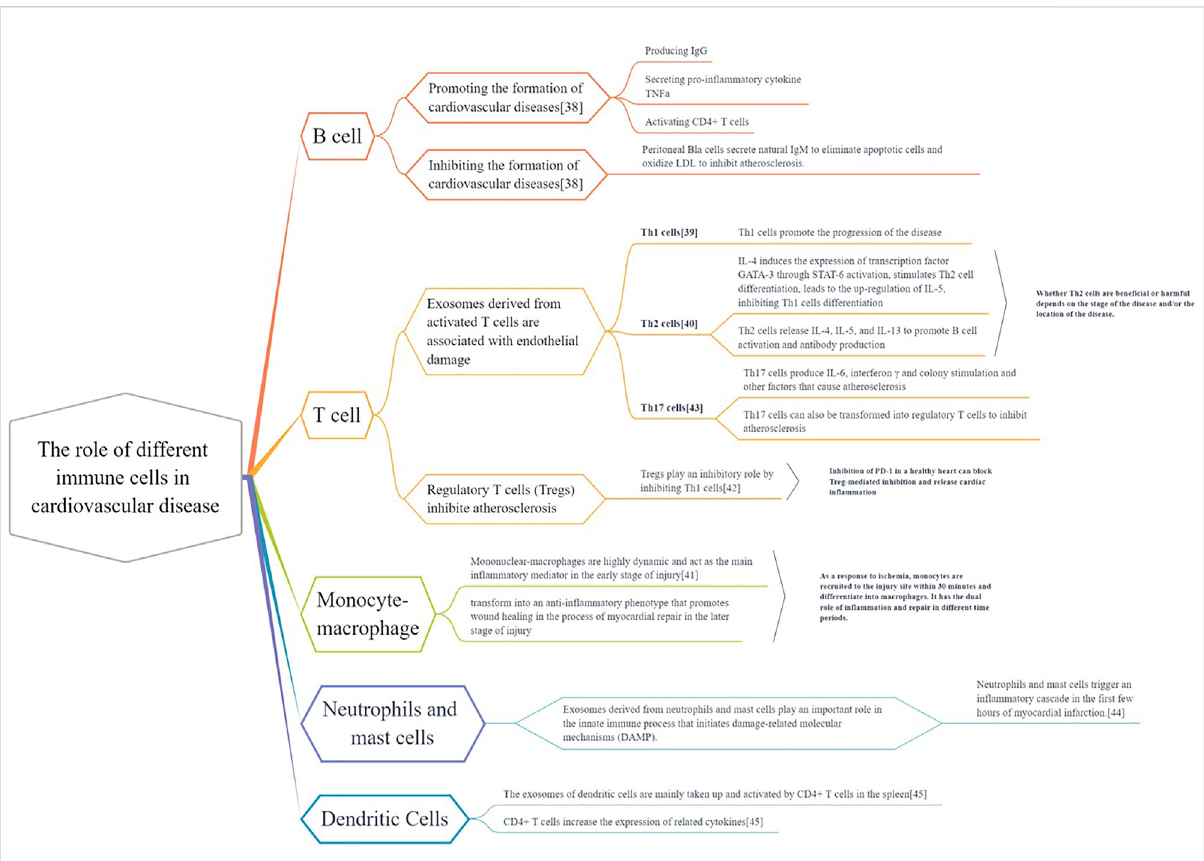
The different roles of immune cells in cardiovascular disease. Various immune cells (B cells, T cells, monocytes, macrophages, dendritic cells, neutrophils, mast cells) exist inheart and vascular system and build up cardiovascular immunologicbarrier.These immune cells play multiple effects on theCardiac andvascularparenchymalcells (cardiomyocytes, endothelialcells andsmoothmusclecells) andcardiac fi broblast.They regulatethe pathological process of cardiovascular diseases, contributing to or delaying the disease